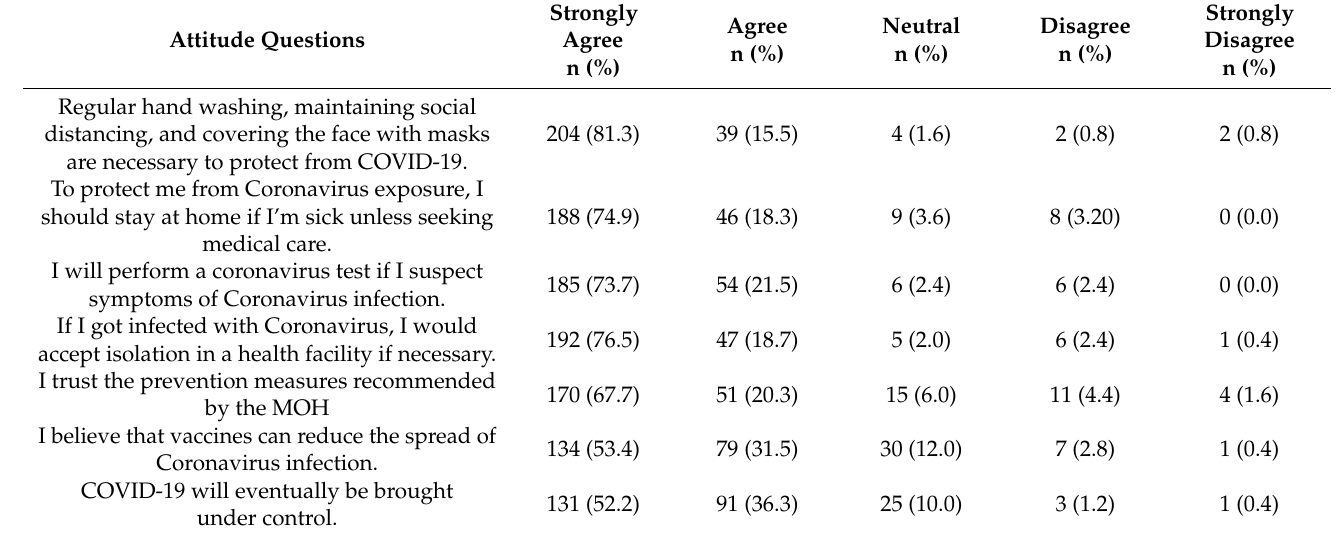
Table 6. Patients’ responses to questions related to attitudes toward COVID-19 (n = 251).